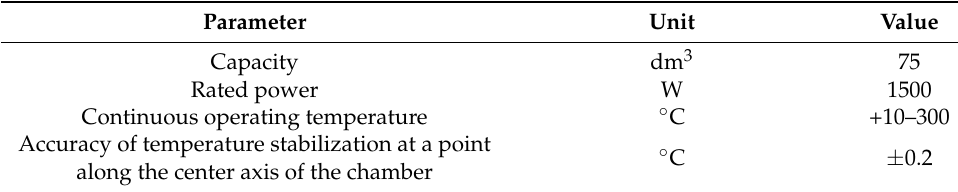
Table 2. Technical specifications of the WAMED KBC-65 W laboratory dryer.